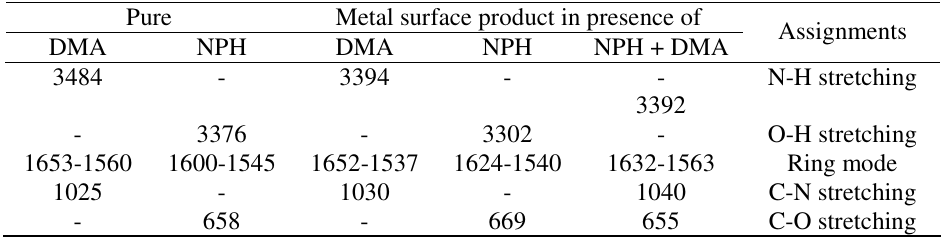
Table 8. Spectral study of FTIR for surface product of binary mixture NPH and EA